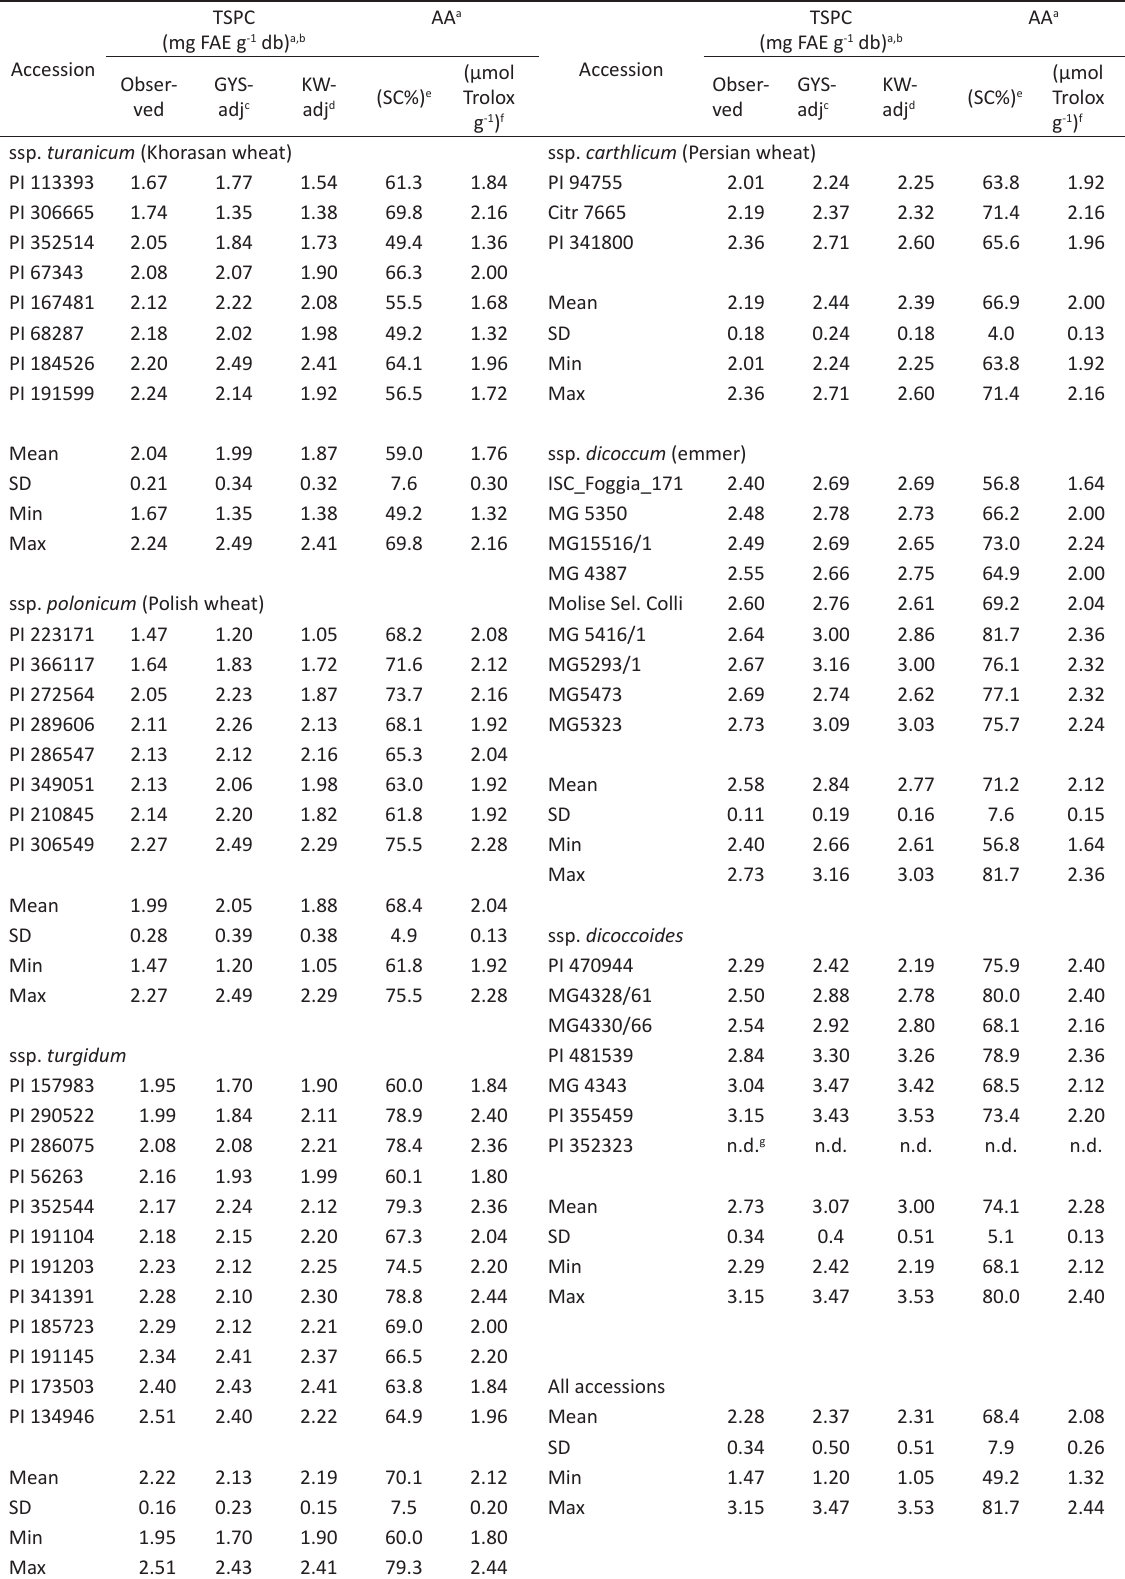
Table 2. Total soluble phenolic compounds (TSPC) and antioxidant activity (AA) of landraces and wild accessions of Triticum turgi- dum included in a tetraploid wheat collection grown at Valenzano (Bari, Italy) in